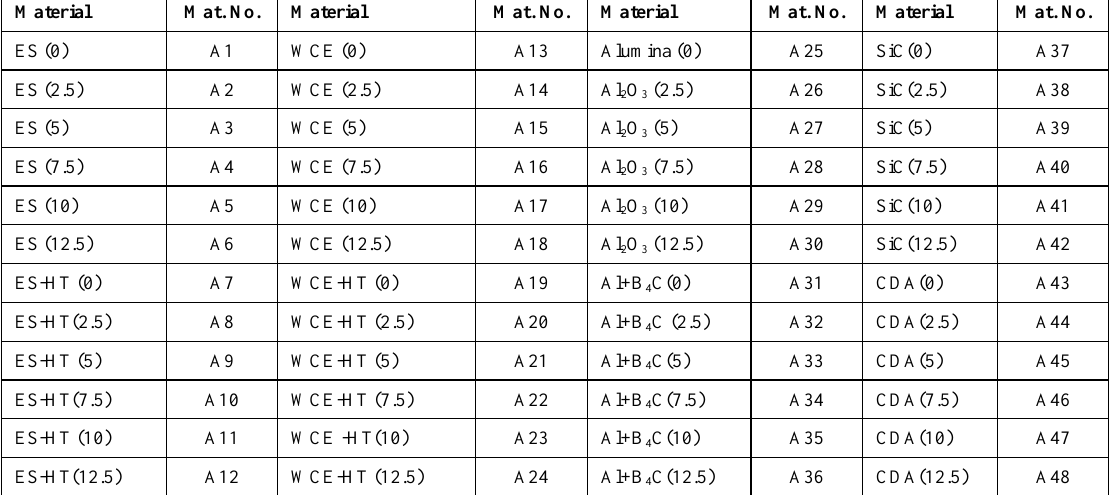
Table 2. Nomenclature of hybrid